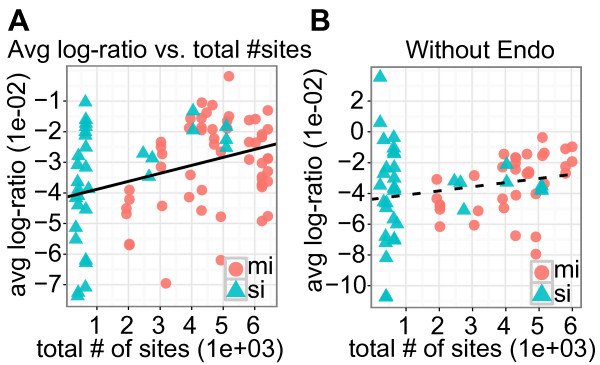
Genes without target sites for endogenous miRNAs show less dilution effects than does the complete set of potential targets. (A) The scatter plot shows the average log ratios for predicted miRNA and siRNA targets as measured by microarrays of 90 over-expression experiments (55 miRNAs and 35 siRNAs) as a function of the miRNAs' and siRNAs' total number of target sites. The line is based on a linear regression and indicates that there is a significant correlation between the total number of target sites and average log ratio (r = 0.37; P < 0.001). (B) The scatter plot shows the average log ratios for the subset of genes that have no predicted target sites for endogenous miRNAs as a function of the miRNAs' and siRNAs' total number of target sites (r = 0.22; P = 0.068). Only the 70 samples assayed in HeLa were included. In both plots, red circles represent miRNAs, and blue triangles represent siRNAs. miRNA, microRNA; siRNA, small interfering RNA.